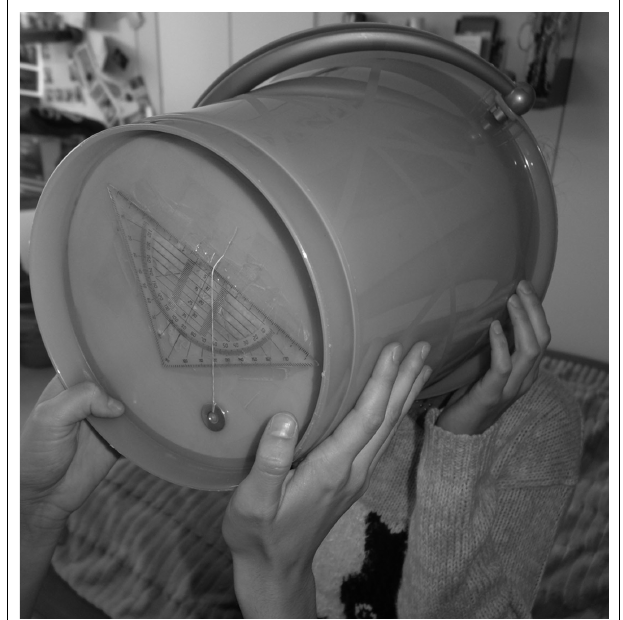
FIGURE 1 | Illustration of the mobile SVV-measuring device (“SVV bucket”) used in this study . SVV adjustment errors were read out from a geometric triangle and a pendulum attached to the outside of the bottom of the bucket. Inside, at the bottom, a black line was drawn and the periphery of the bottom was covered to avoid light shining through the bottom of the bucket and provide external visual